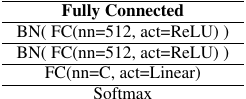
Figure 2. The overview of the training procedure of S1 S 2 GKD. Firstly, (a) the multi-source CNN model (teacher network) is trained leveraging both radar and optical SITS; successively (b) a Multilayer Perceptron (student network) is trained considering only radar SITS as input data and it is forced to imitate (or distill) as much as possible the behavior of the multi-source model considering both features extraction and softmax decision. At test time, the student model will be deployed to predict the class values of unlabeled samples defined only on radar SITS.